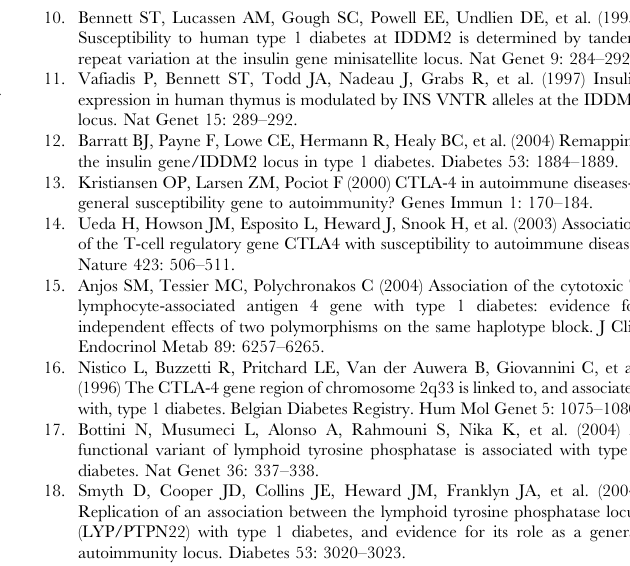
Figure S2 Regional plot of the EFRB associated region. – log10( P -values) are shown for all SNPs in the region and color of circles indicates degree of LD with the most associated SNP in the region. Recombination rate is overlaid on the figure and the position with respect to genes is shown at the bottom. Figure S3 Regional plot of the LMO7 associated region. – log10( P -values) are shown for all SNPs in the region and color of circles indicates degree of LD with the most associated SNP in the region. Recombination rate is overlaid on the figure and the position with respect to genes is shown at the bottom. Figure S4 Regional plot of the LOC100128081 associated region. –log10( P -values) are shown for all SNPs in the region and color of circles indicates degree of LD with the most associated SNP in the region. Recombination rate is overlaid on the figure and the position with respect to genes is shown at the bottom. Figure S5 Regional plot of the Chromosome 6 associated region. –log10( P -values) are shown for all SNPs in the region and color of circles indicates degree of LD with the most associated SNP in the region. Recombination rate is overlaid on the figure and the position with respect to genes is shown at the bottom. Figure S6 Regional plot of the Chromosome 8 associated region. –log10( P -values) are shown for all SNPs in the region and color of circles indicates degree of LD with the most associated SNP in the region. Recombination rate is overlaid on the figure and the position with respect to genes is shown at the bottom. Figure S7 Regional plot of the Chromosome 2 FOSL2 associated region. –log10( P -values) are shown for all SNPs in the region and color of circles indicates degree of LD with the most associated